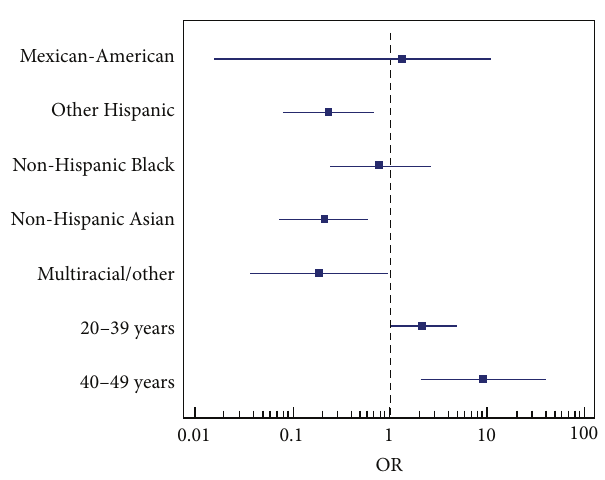
∗ Note: each row represents output of one simple logistic regression between consent (dependent variable) and the independent variable listed in this column.